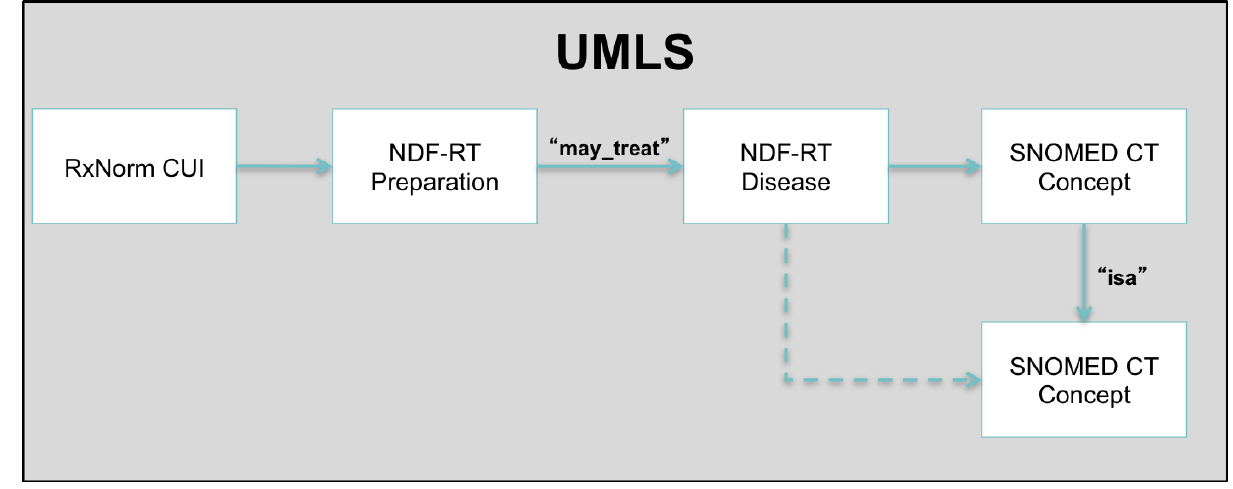
Figure 3. SMART RxNorm medications are mapped to SNOMED CT problems using the NDF-RT “may treat” linkage as intermediary. Adapted from [26]; used with permission.